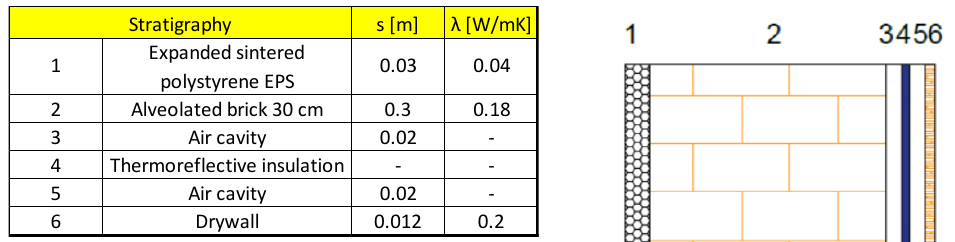
Figure A10. Wall type 3.3: transmittance check for the three main Italian climatic zones. In are blue the heat-reflective materials which respect all the limits.